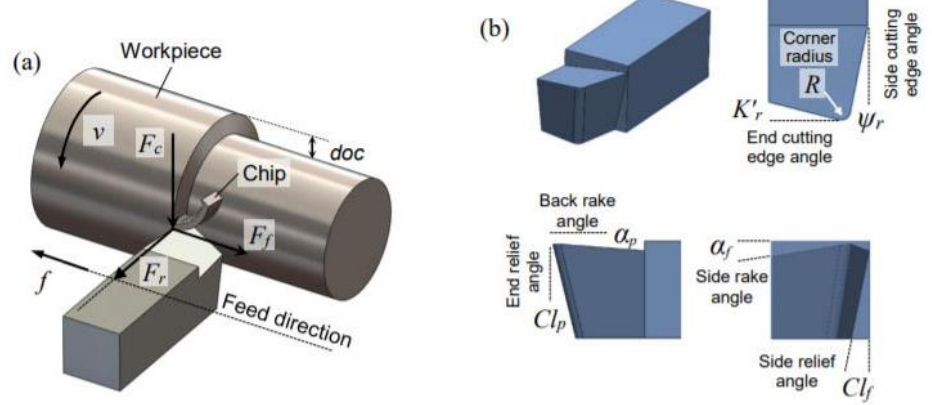
Figure 2: Oblique cutting process (a) process schematic, (b) tool